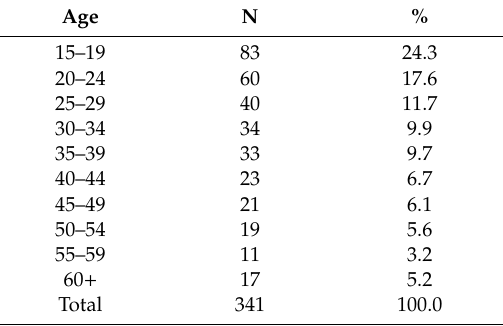
Table 1. Participants’ age profile